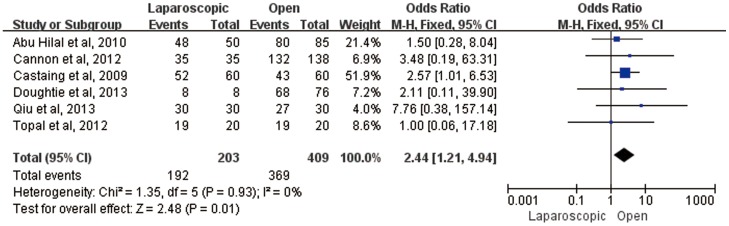
Forest plot of oncological results on R0 resection.